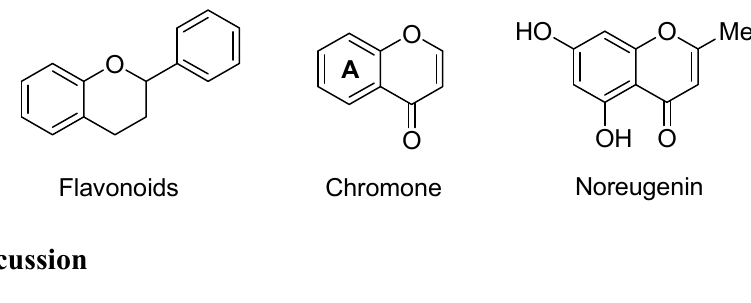
Figure 1. Flavonoid core and chromone structure.